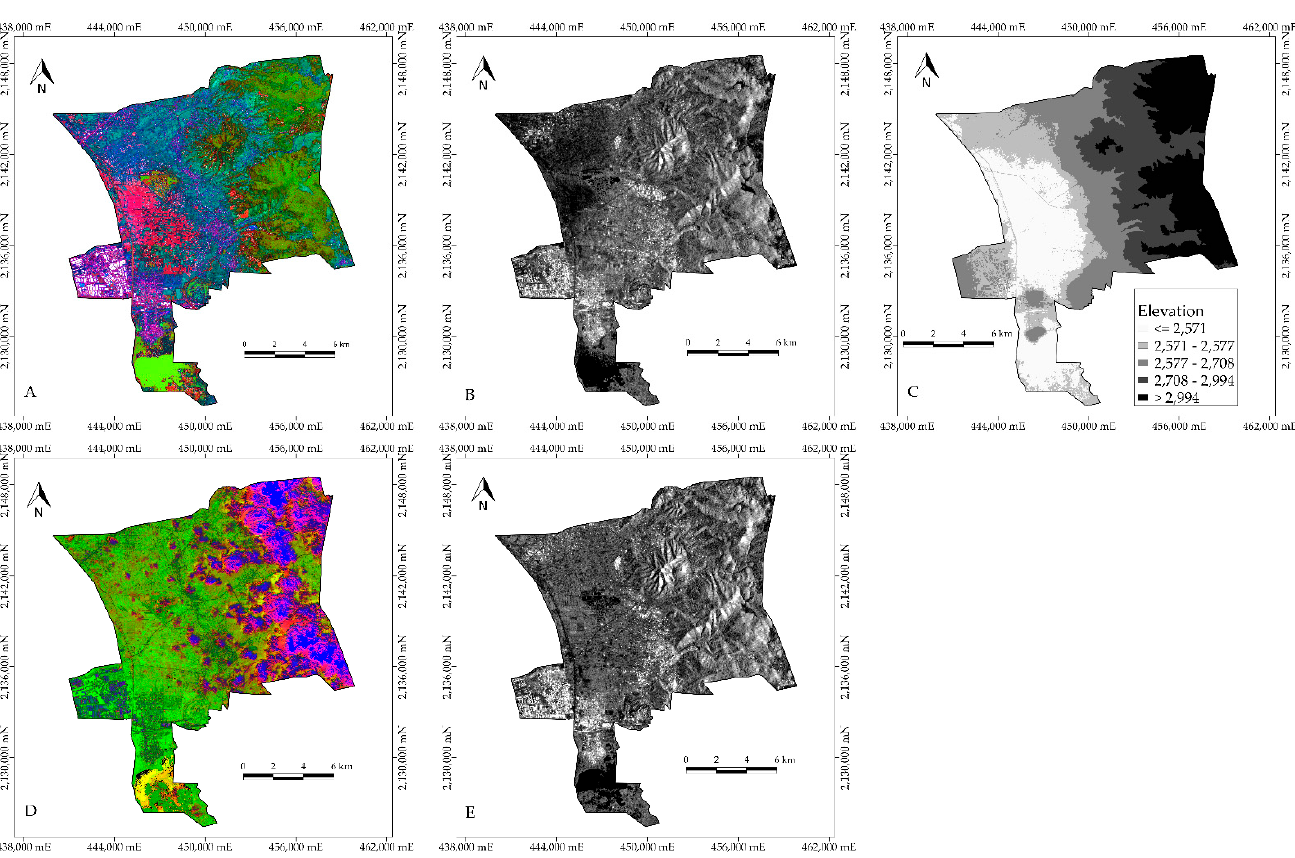
Figure 5. Input images for the evaluation of machine learning algorithms: Sentinel-2 ( A , D ) and Sentinel-1 ( B , E ) for the dry and rainy seasons, respectively, and the DEM ( C ). Table 4. Values of performance indicators obtained using the GB algorithm for all combinations for the dry and rainy